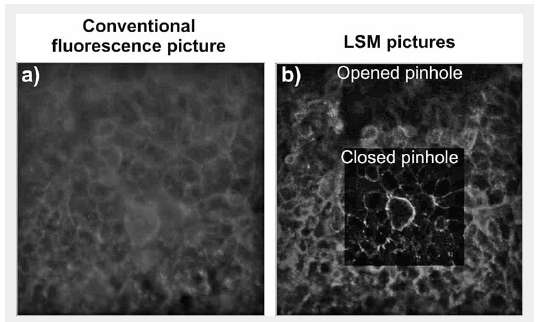
Comparison of conventional fluorescence microscopy and LSM. Epithelial cells (16HBE14o-) were grown to confluence and then fixed and stained for F-Actin (Phalloidin-Rhodamine). a) A micrograph taken with a CCD camera is represented, b) shows two pictures taken with Zeiss 510 Meta laser scanning microscope using either an opened pinhole or a closed pinhole. All pictures were taken from the same region.